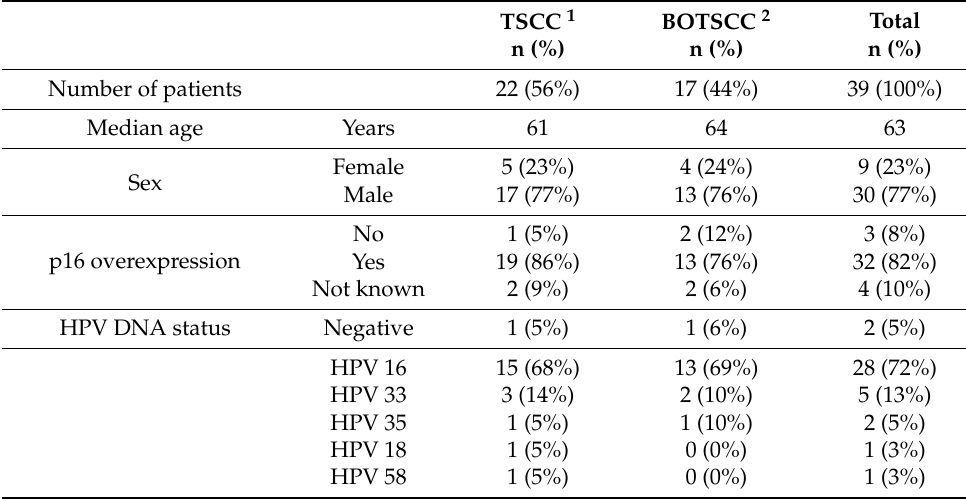
Table 2. Patients treated with a neck dissection (ND) and their